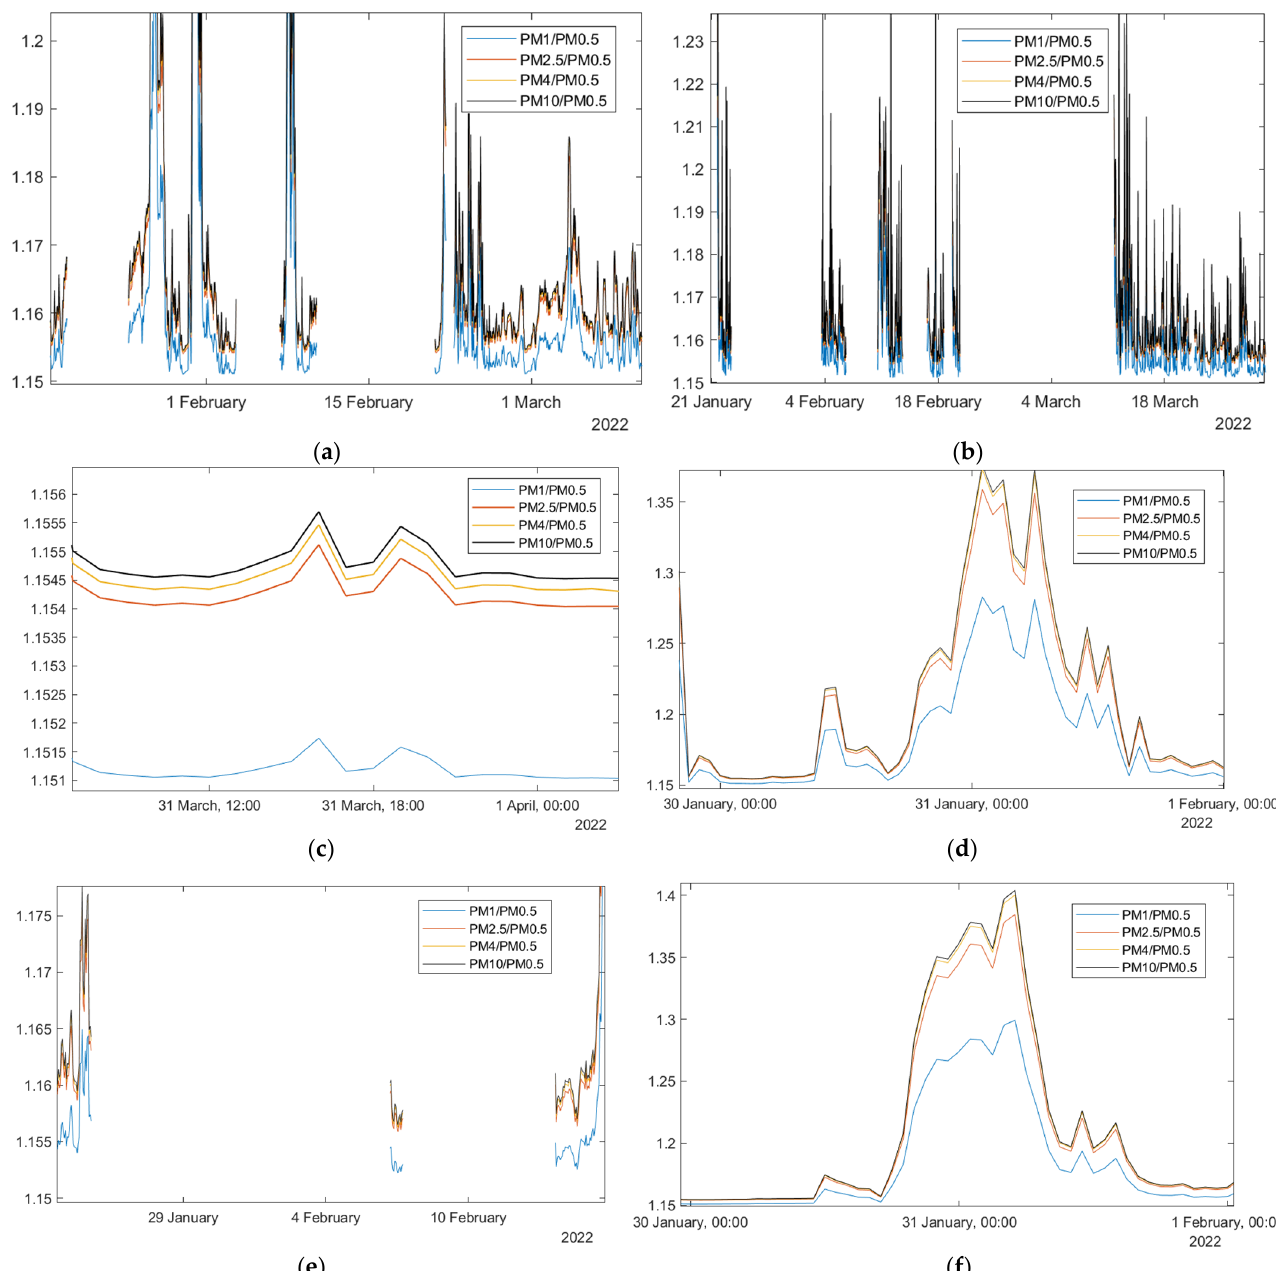
Figure 8. Examples of changes in the ratios of PM1, PM2.5, PM4, PM10 vs. PM0.5 number concentrations measured at: ( a ) DTIEE (Košice), ( b ) Füzérkomlós village, ( c ) Snina town, ( d ) Habura village, ( e ) Košice town (measurement site #2) ( f ) DTIEE—time slice selected for the same interval as Habura in ( d ).